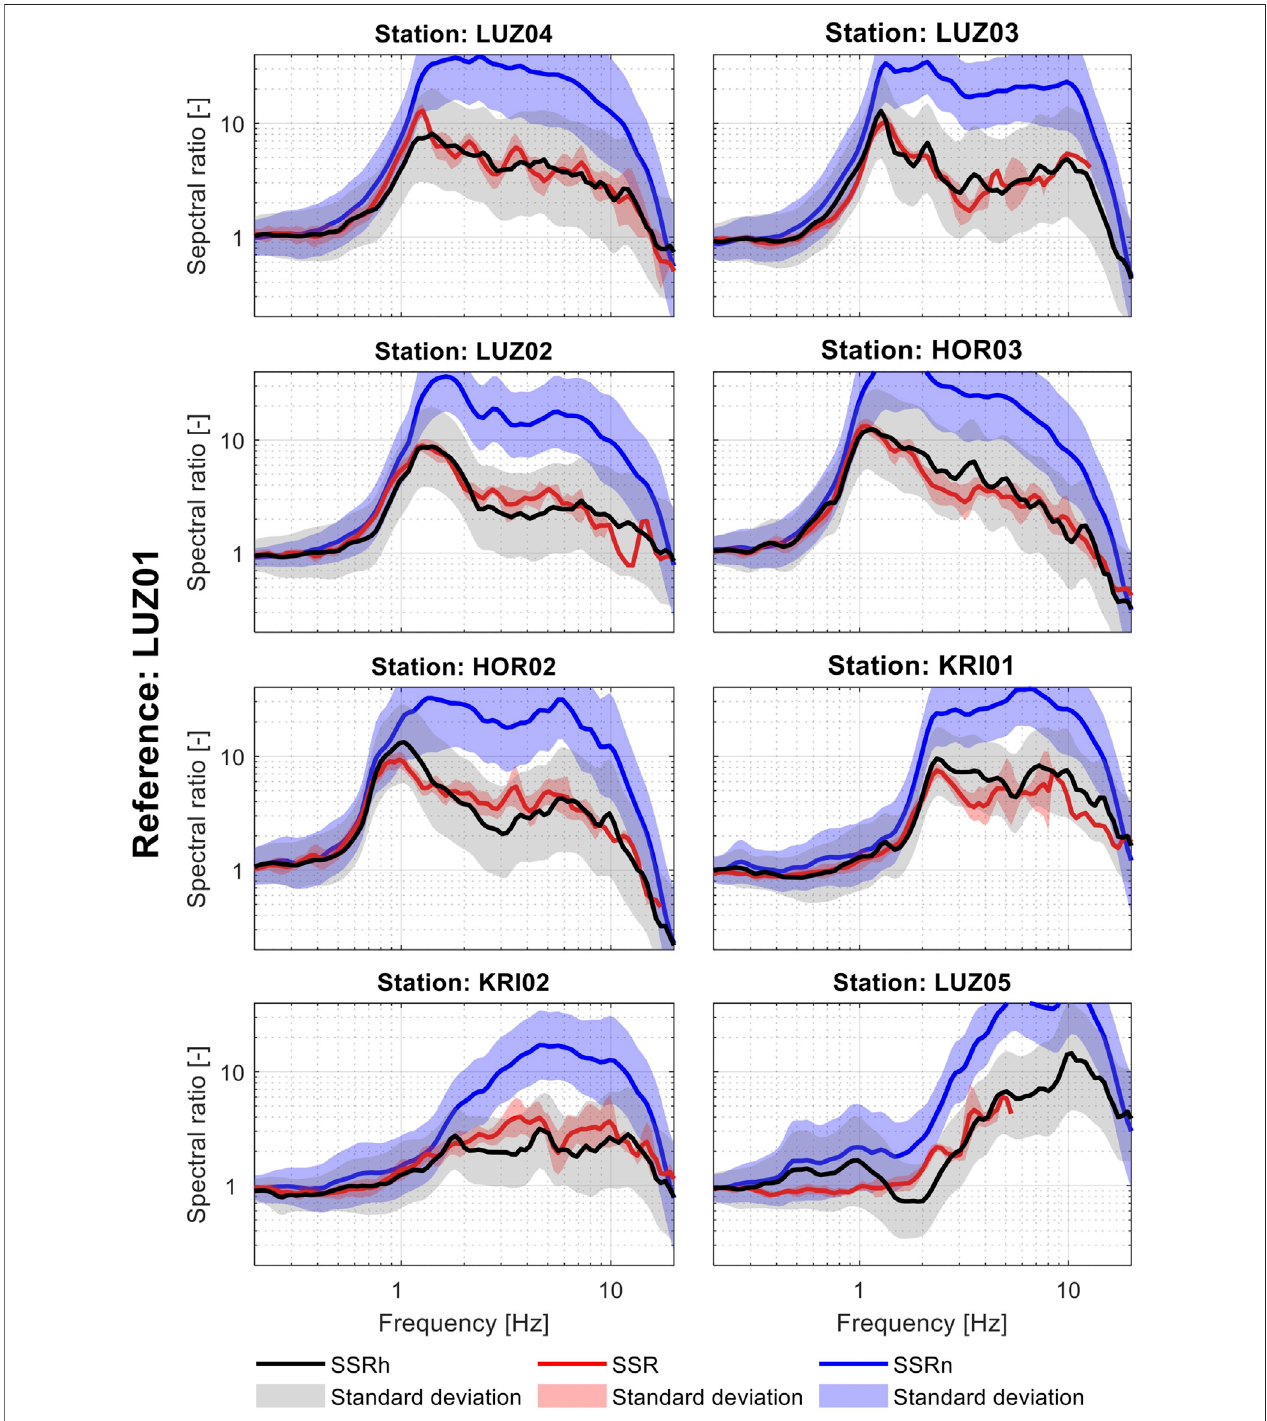
FIGURE 7 | Comparison of the relative ampli fi cation functions for sedimentary sites using the SSR, SSRn, and SSRh methods with standard deviation (reference — rock station LUZ01).